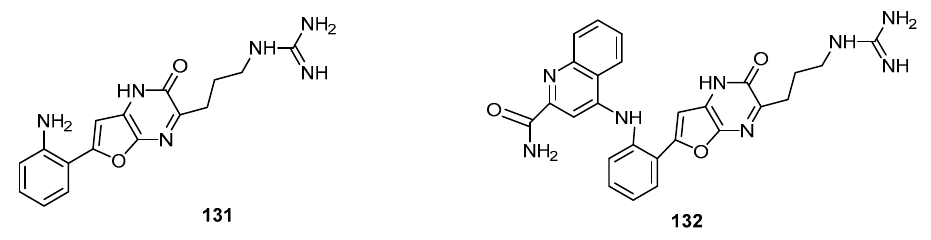
Figure 35. Chemical structures of hyrtioseragamine A ( 131 ) and hyrtioseragamine B ( 132 ).